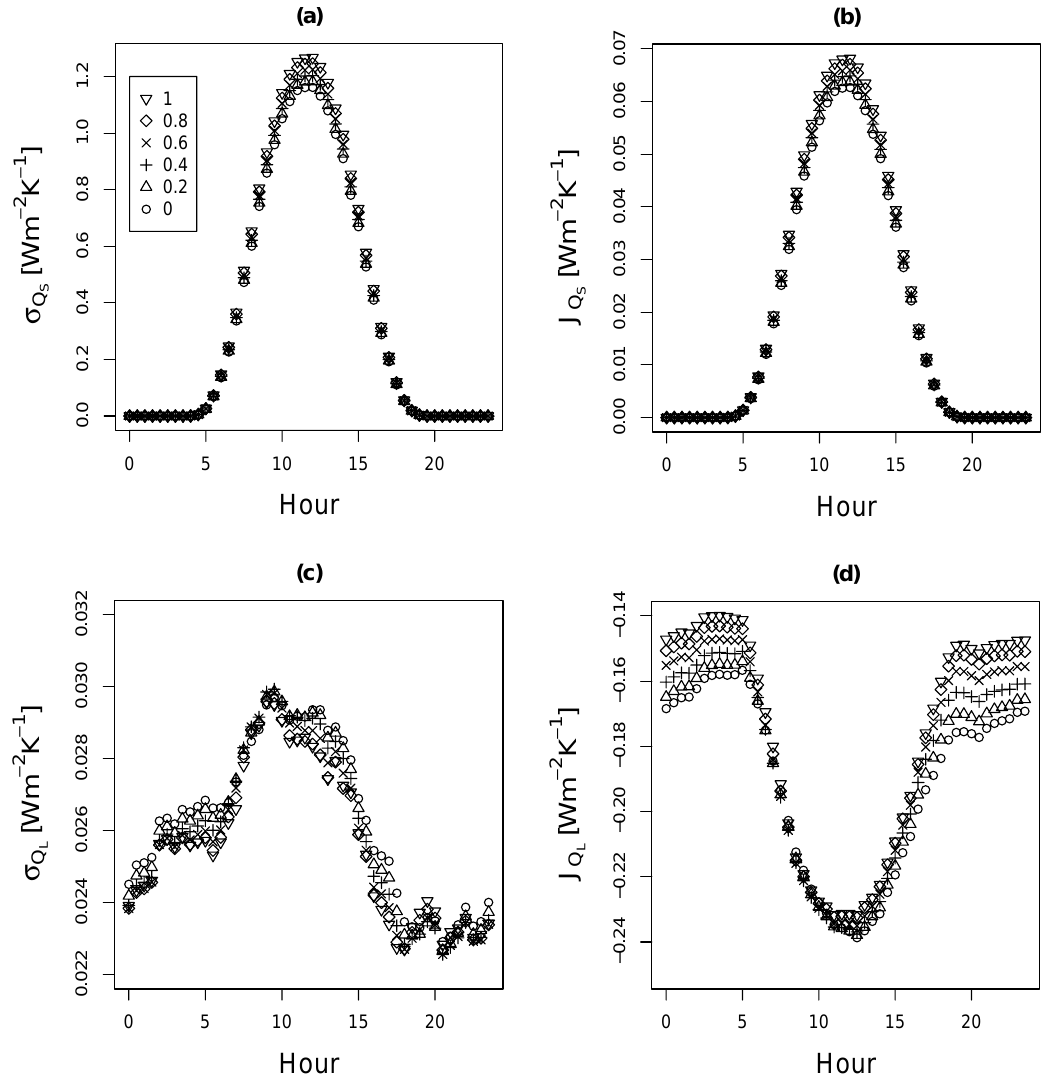
Fig. 6. Mean diurnal entropy terms associated with (a) production due to to conversion of shortwave radiant energy, (b) transport due to shortwave radiation (c) production due to longwave radiant exchange and (d) transport associated with longwave radiation as a function of fractional vegetation